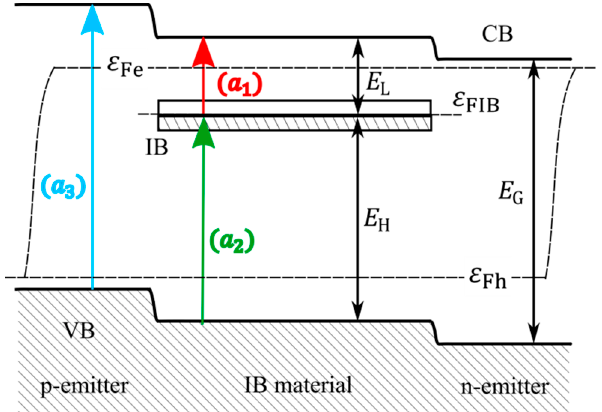
Figure 1. Energy band diagram of an intermediate band solar cell (IBSC). The three energy bands and the absorption processes related to them are shown.